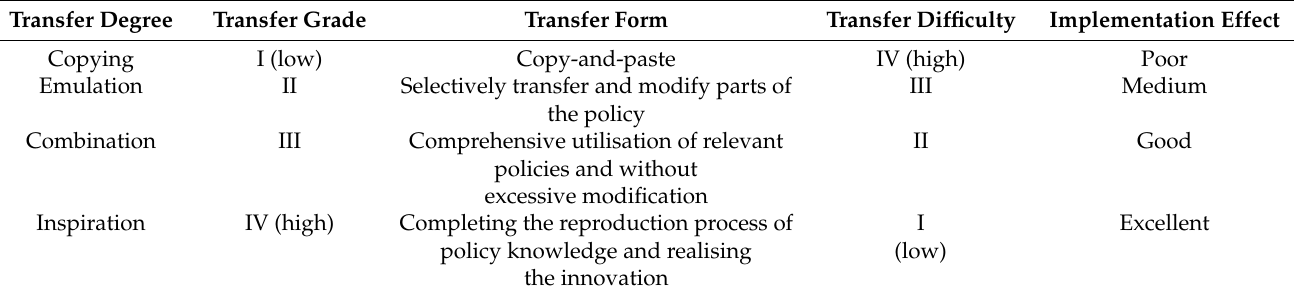
Table 9. “Degree–Effect” analysis of policy